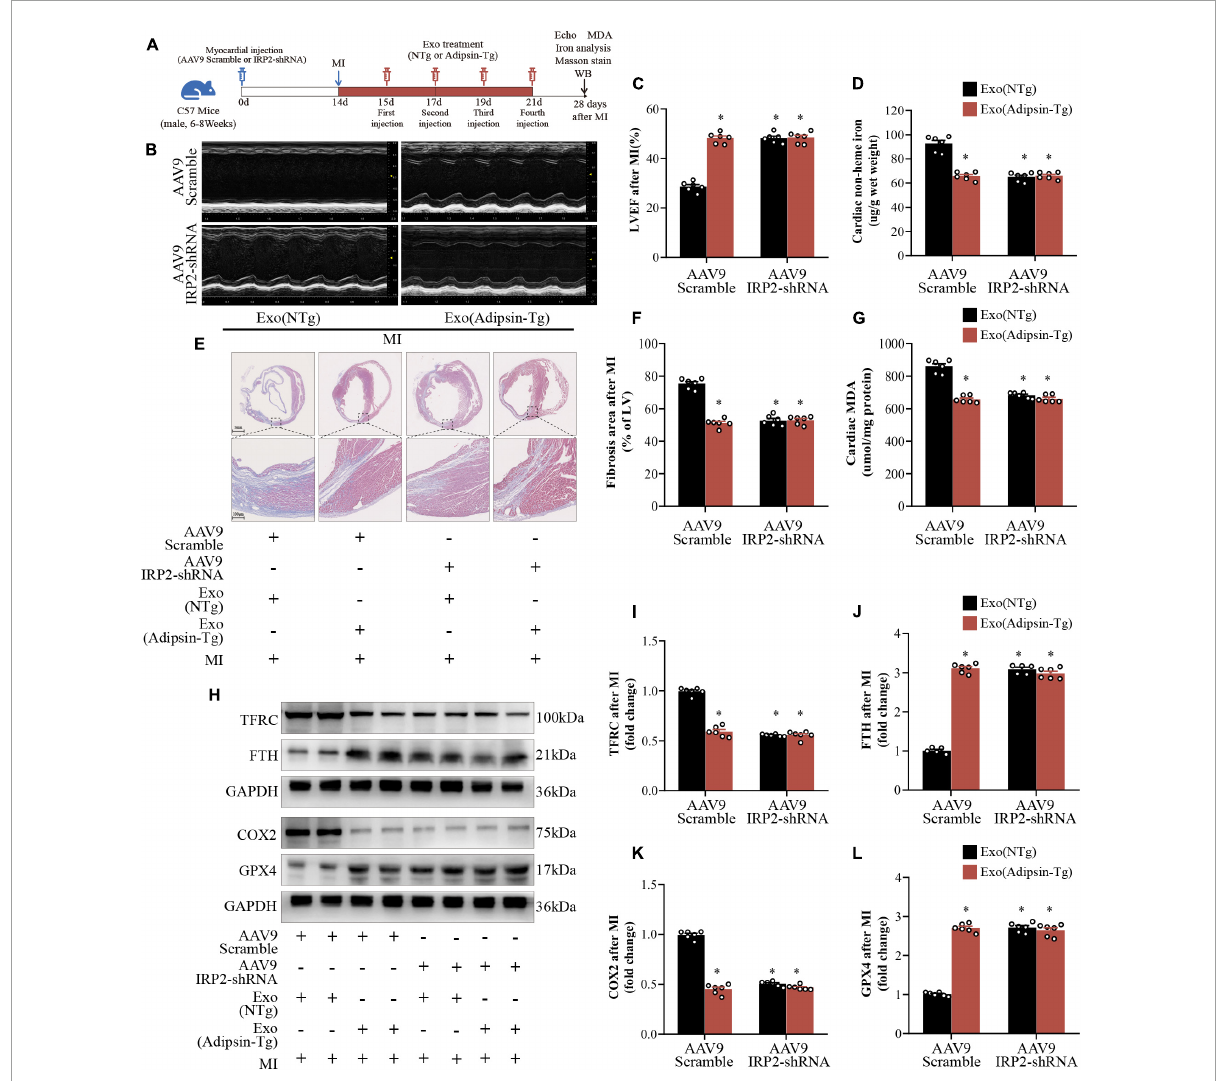
FIGURE7 Irp2 is essential to Adipsin-offered cardioprotection. (A) Flowchart of the study design. Myocardial infarction surgery was performed 14 days after injection of AAV9 (Scramble or IRP2-shRNA) at the area of the myocardium. Following that, MI mice were injected four times with exosomes isolated from Adipsin-Tg or NTg mice’s pericardial adipose tissues. Cardiac function was assessed 28 days after MI surgery. Each group n = 6. (B,C) Representative echocardiographic images and left ventricular ejection fraction (LVEF) analysis. Each group n = 6. * p < 0.05 vs. AAV9-Scramble + Exo (NTg) group. (D) Non-heme iron levels were measured in the peri-infarct region of heart. Each group n = 6. * p < 0.05 vs. AAV9-Scramble + Exo (NTg) group. (E,F) Quantification of fibrotic area and representative images of Masson’s trichrome staining of the transverse planes post myocardial infarction. Each group n = 6. * p < 0.05 vs. AAV9-Scramble + Exo (NTg) group. (G) Malondialdehyde (MDA) levels in the peri-infarct region of heart. Each group n = 6. * p < 0.05 vs. AAV9-Scramble + Exo (NTg) group. (H–L) TFRC, FTH, COX2, and GPX4 proteins were measured by Western blots. Each group n = 6. * p < 0.05 vs. AAV9-Scramble + Exo (NTg) group. Data were mean ± SEM, and one-way ANOVA was used for statistical